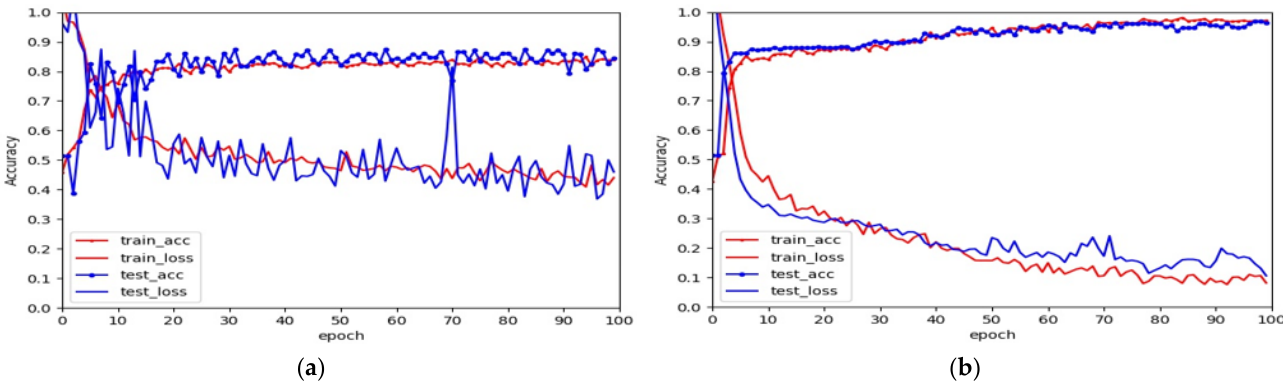
Figure 10. ( a ) Accuracy and loss function of training sets and validation sets of the vgg16 network model trained with real side-scan sonar images. ( b ) Accuracy and loss function of the training sets and validation sets of the pre-trained vgg19 network model fine-tuned with real side-scan sonar